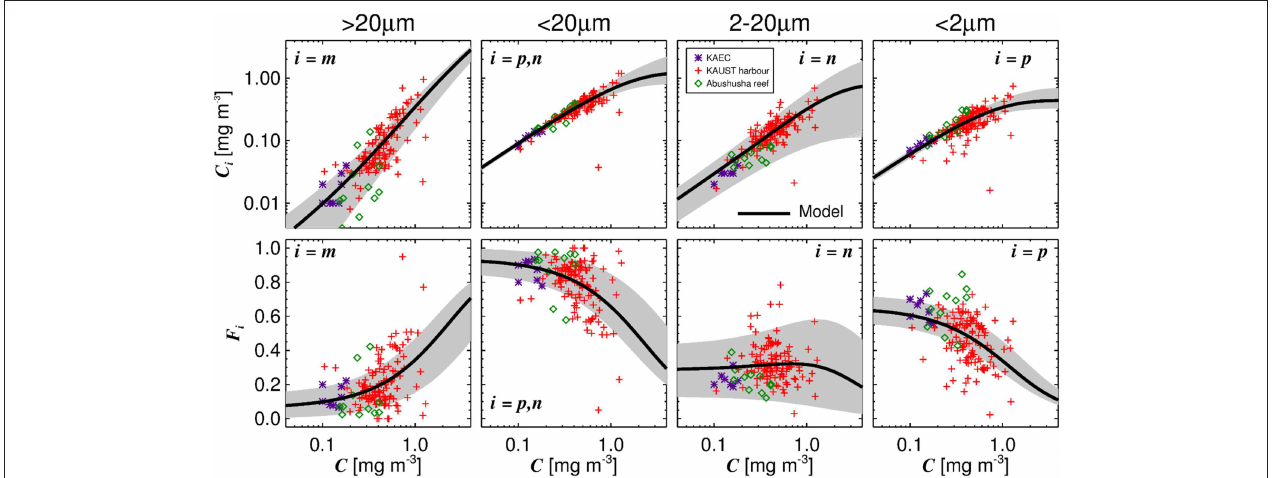
FIGURE 2 | Fits of the three-component model to size-fractionated filtration (SFF) data collected in the study. Top row shows the absolute chlorophyll concentrations ( C m , C p , n , C n , and C p ) and bottom row the fractions ( F m , F p , n , F n , and F p ) plotted as a function of total chlorophyll ( C ), with the tuned three-component model (parameters from Table 2 ) overlain. Gray shading represents a model ensemble varying parameters between their confidence intervals ( Table 2